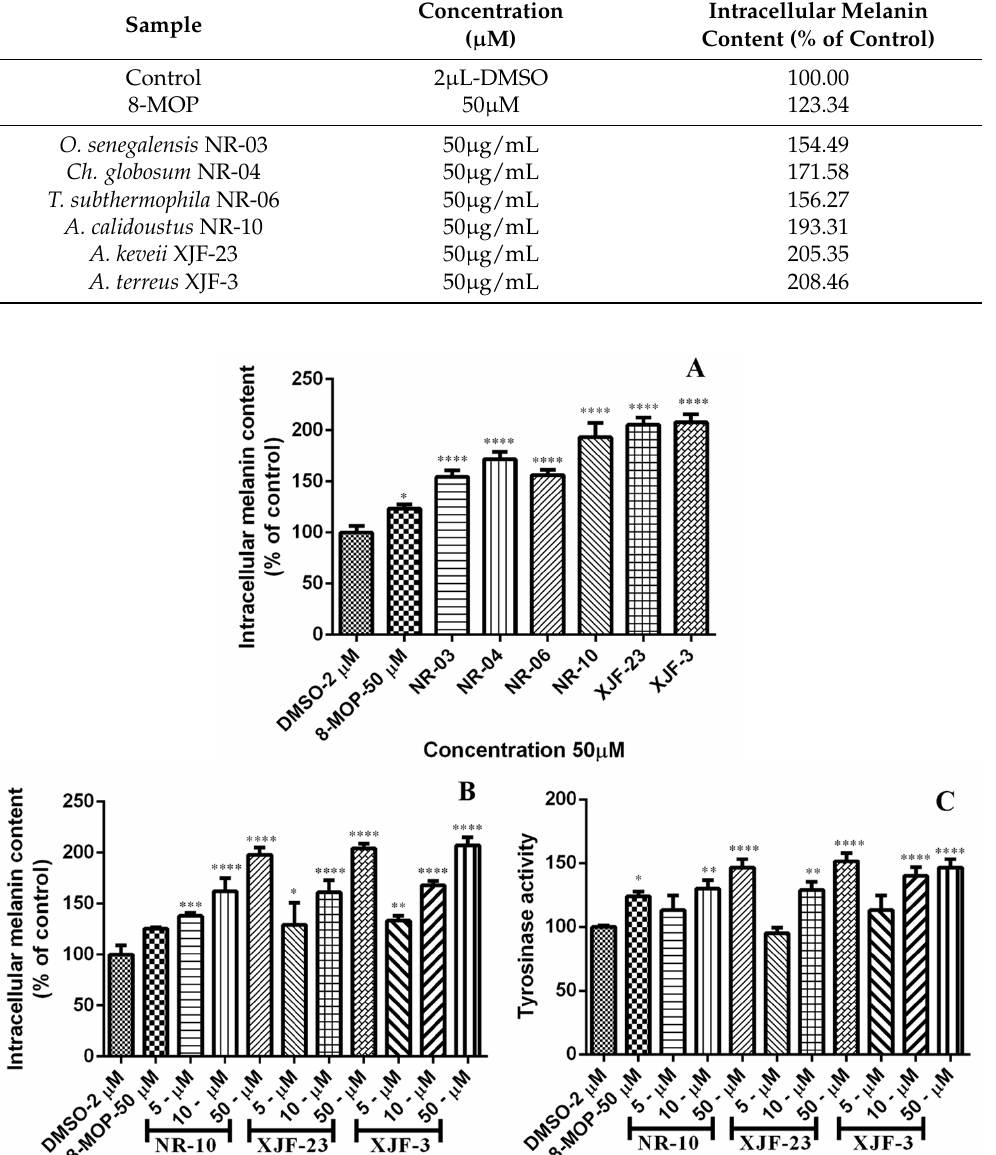
Table 4. Stimulation of melanin content of B16 cells by total crude extracts of the endophytic fungi.